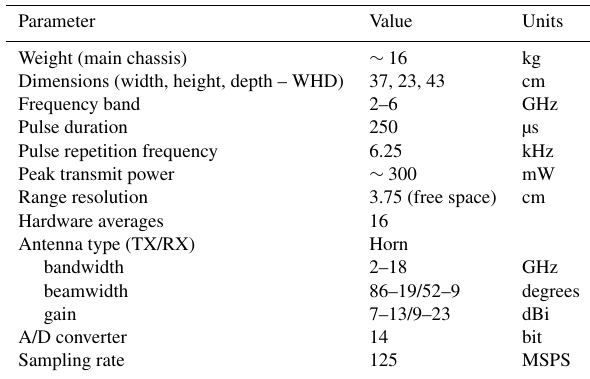
Table 1. System parameters in